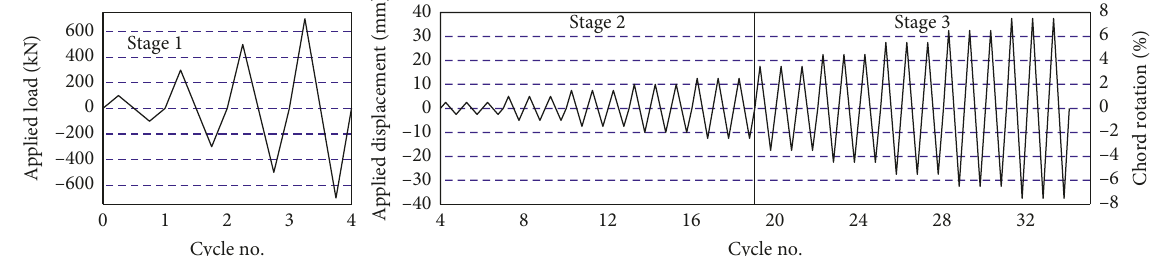
Figure 3: Lateral loading protocol of specimen